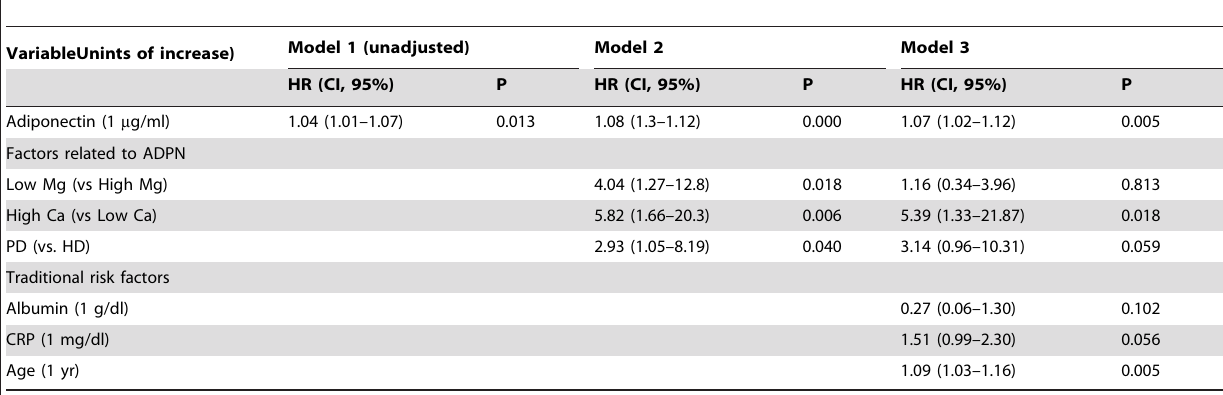
Table 4. Crude and adjusted hazard ratios of serum adiponectin (per 1 m g/ml) for prediction of all-cause mortality in 74 prevalent ESRD patients.